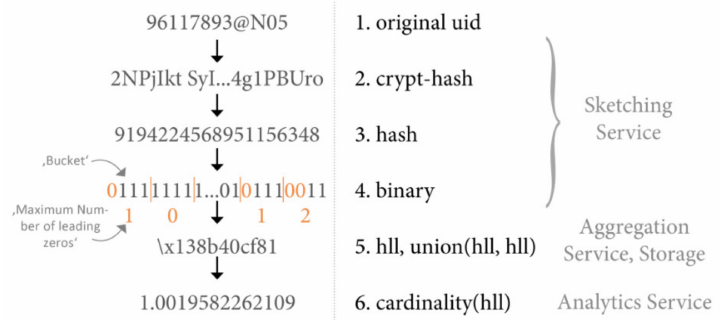
Figure 2. Transformation steps applied to a single character string, such as a user ID, for generating a HyperLogLog (HLL) set, and the final estimation of cardinality (Example values were generated with real data, but di ff erent values may be produced based on various parameter